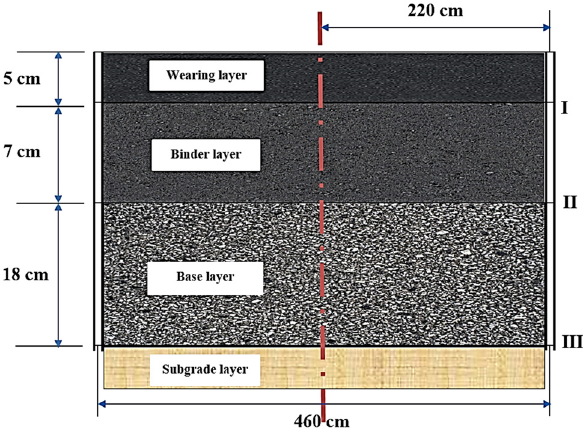
Figure 10: The control section A – A in the road